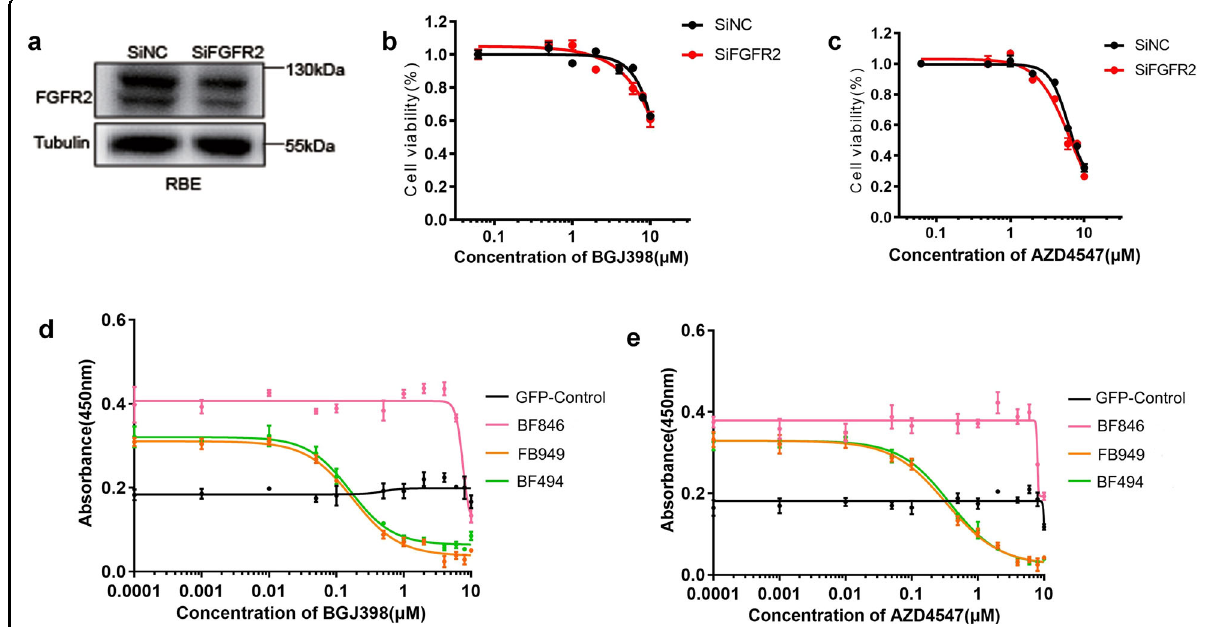
Fig. 5 Response of RBE cells expressing FGFR2 fusions to FGFR2 -selective SMKIs BGJ398 and AZD4547. siRNA was used to interfere the expression of endogenous FGFR2 ( a ). siRNA interference did not change the response of RBE cells to BGJ398 ( b ) or AZD4547 ( c ). Dose-response curves for BGJ398 ( d ) and AZD4547 ( e ) in RBE cells. The viability of RBE cells expressing different FGFR2 fusions was detected by CCK8 assay after treatment with indicated concentration of BGJ398 or